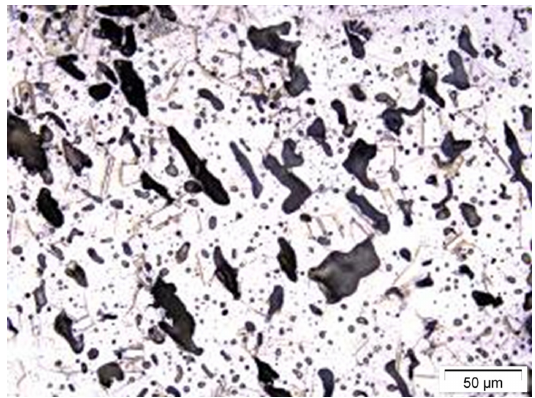
Figure 7. Microstructure of Hadfield steel sample obtained in a cycle with high cooling rate (50 °C/min). Author: Renan